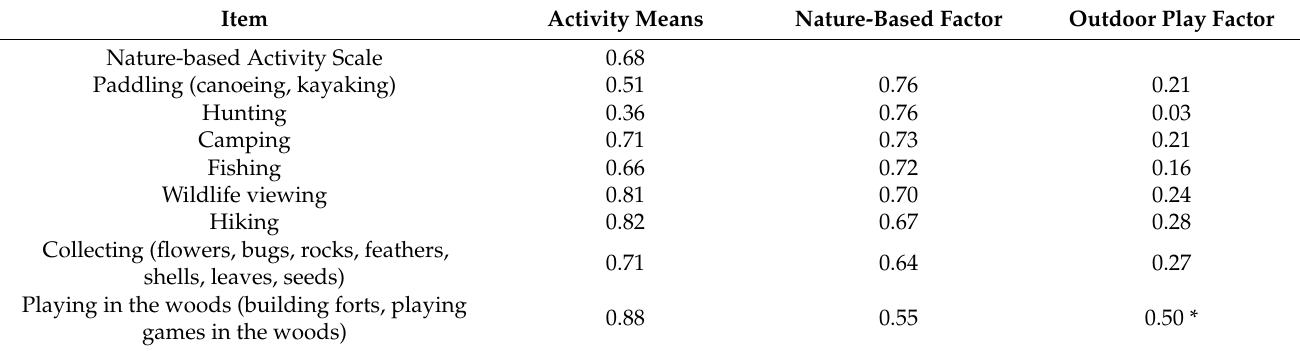
Table 2. Principal component factor analysis of adolescent pre COVID-19 pandemic outdoor activity participation